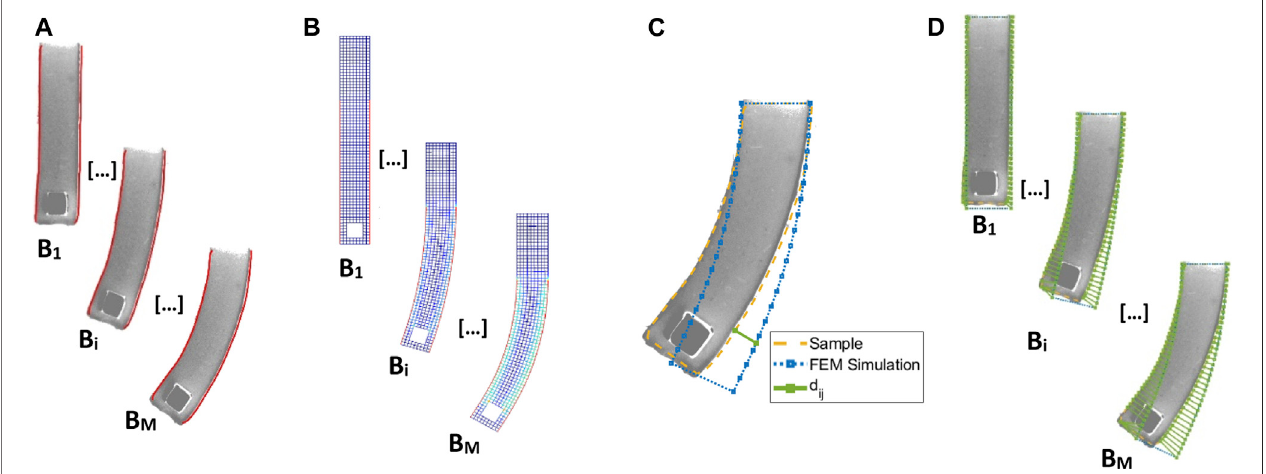
FIGURE 5 | The steps used to obtain the distance between the FE simulation and the experimental data (see Eq. 10 ): (A) image segmentation and feature extraction ofthe left and right edge ofthe robot; (B) FEM simulationfor achosenmodel and parameters p (cid:1) [ C 1 ... C N , α 1 ... α M ] ; (C) distance evaluation d ij (green line) for each point j of the FEM simulation from the experimental data; (D) evaluation of the variance for each value of magnetic fl ux density B i